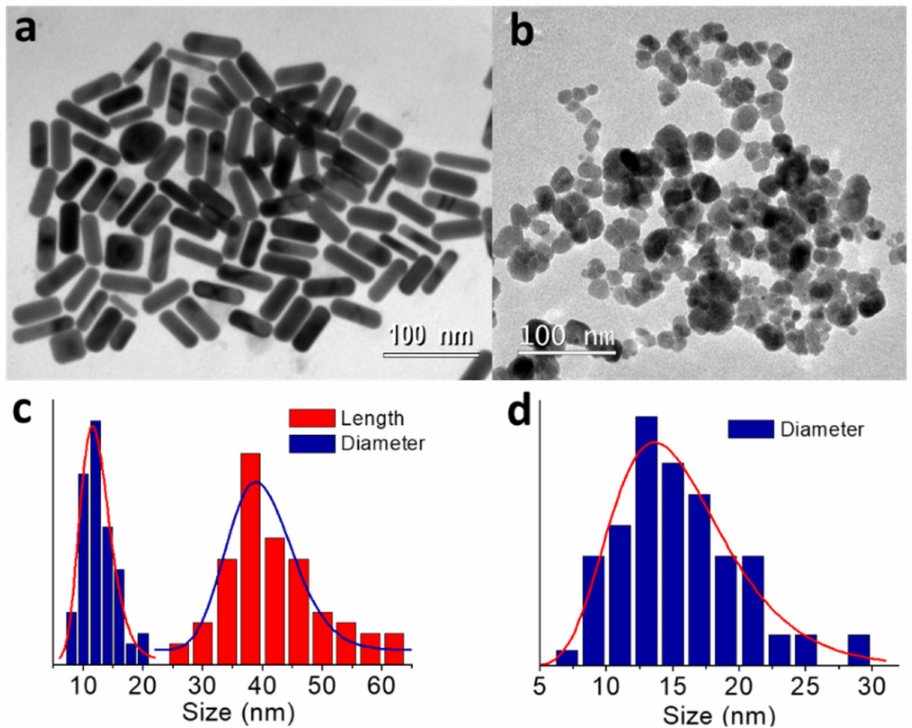
Figure 1. TEM images of the ( a ) AuNRs and ( b ) IONPs used in the hybridization study. ( c ) Distri- bution of AuNRs’ length (red) and diameter (blue) measured in TEM images. ( d ) Distribution of IONPs’ diameter measured in TEM images. The curves in ( c , d ) indicate the log-normal fitting of each